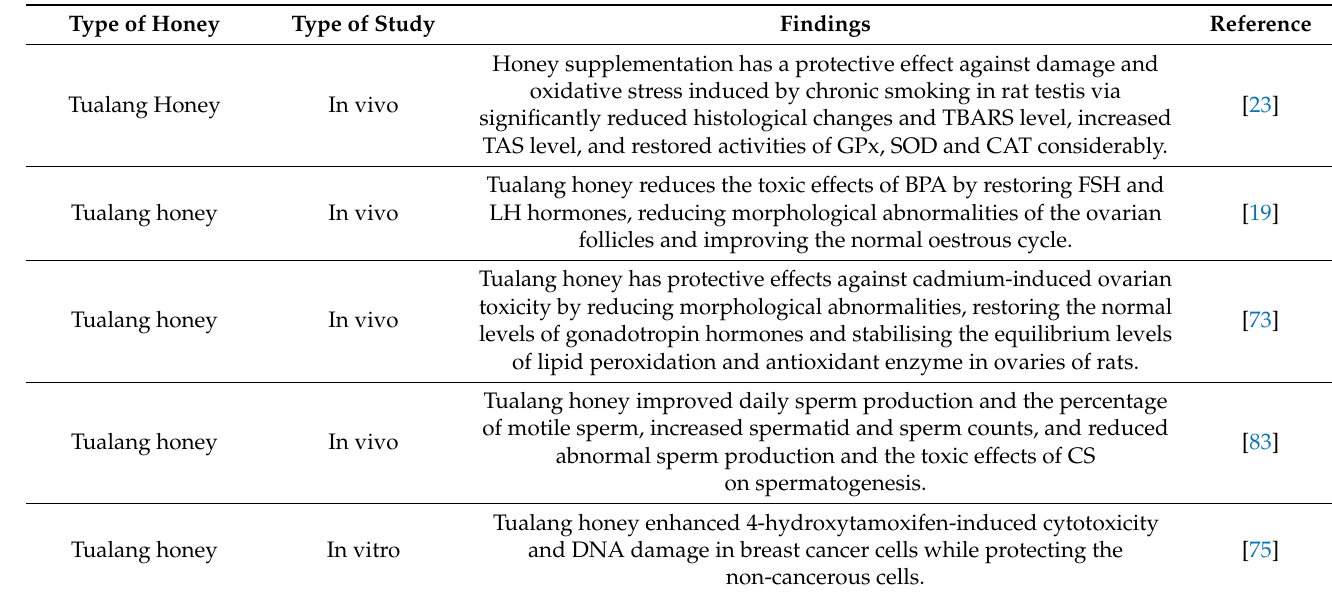
Table 3. Summary of the roles of honey against toxicity in the reproductive